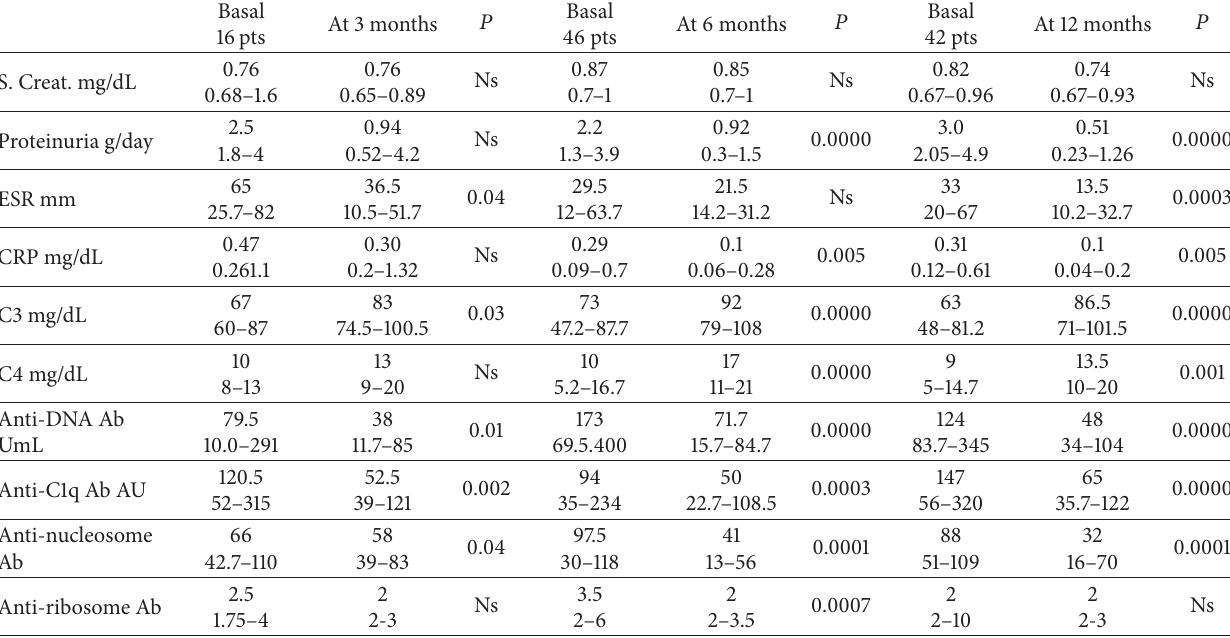
Table 4: Outcome of clinical and immunological parameters at 3, 6, and 12 months after the beginning of induction therapy.